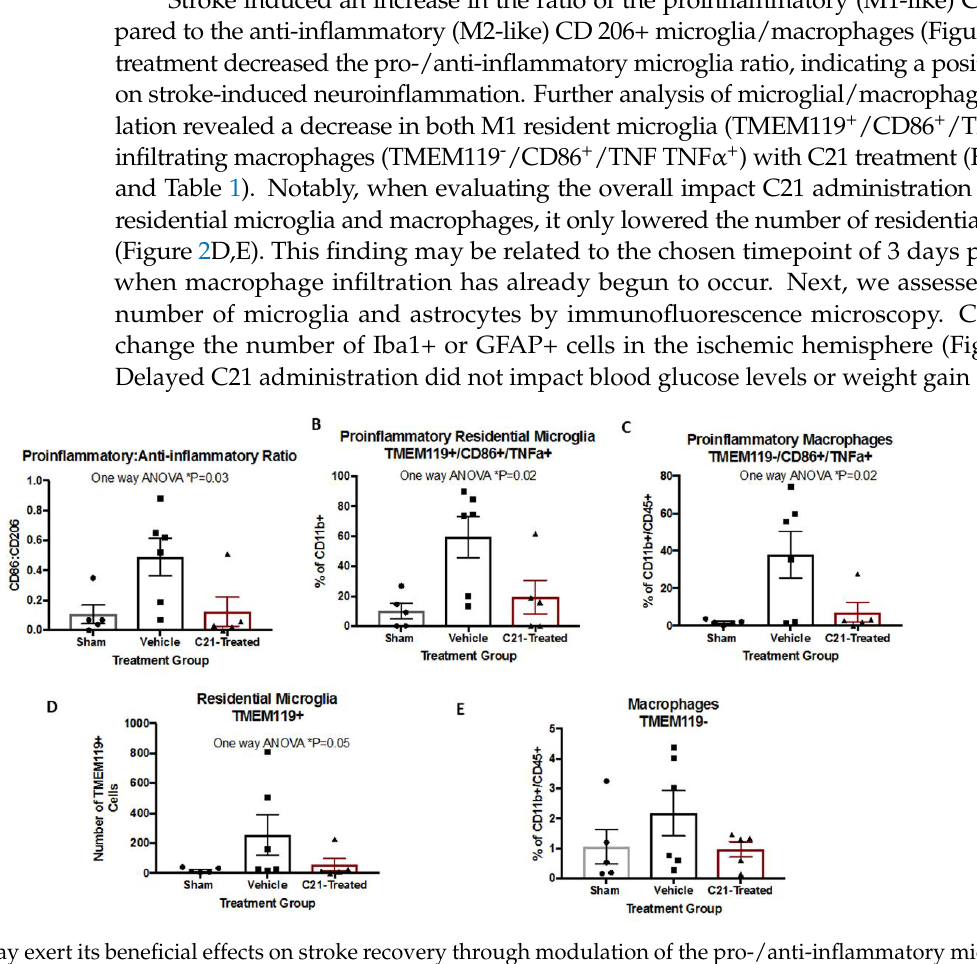
Figure 2. C21 may exert its beneficial effects on stroke recovery through modulation of the pro-/anti-inflammatory microglia ratio in diabetic animals. ( A ) Treatment with C21 lowered the M1:M2 ratio in female diabetic rats 4 weeks after stroke ( p = 0.03). C21 administration lowered both the ( B ) M1 residential microglia and the ( C ) M1 macrophages ( p = 0.02). One-way ANOVA (n = 5–6/group). ( D ) Delayed administration of C21 may act through halting the activation of residential microglia ( p = 0.05). ( E ) It also did not impact the percentage of activated macrophages as measured by flow cytometry, as indicated in Table 1. It did however reduce the activation of residential microglia. One-way ANOVA (n =